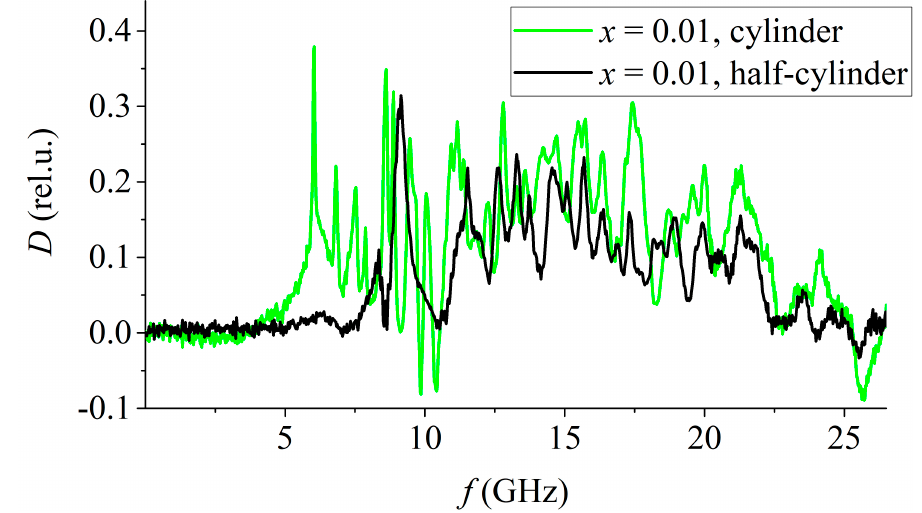
Figure 10. Frequency dependence of the absorption coefficient of SS samples of the PZT system of various shapes.